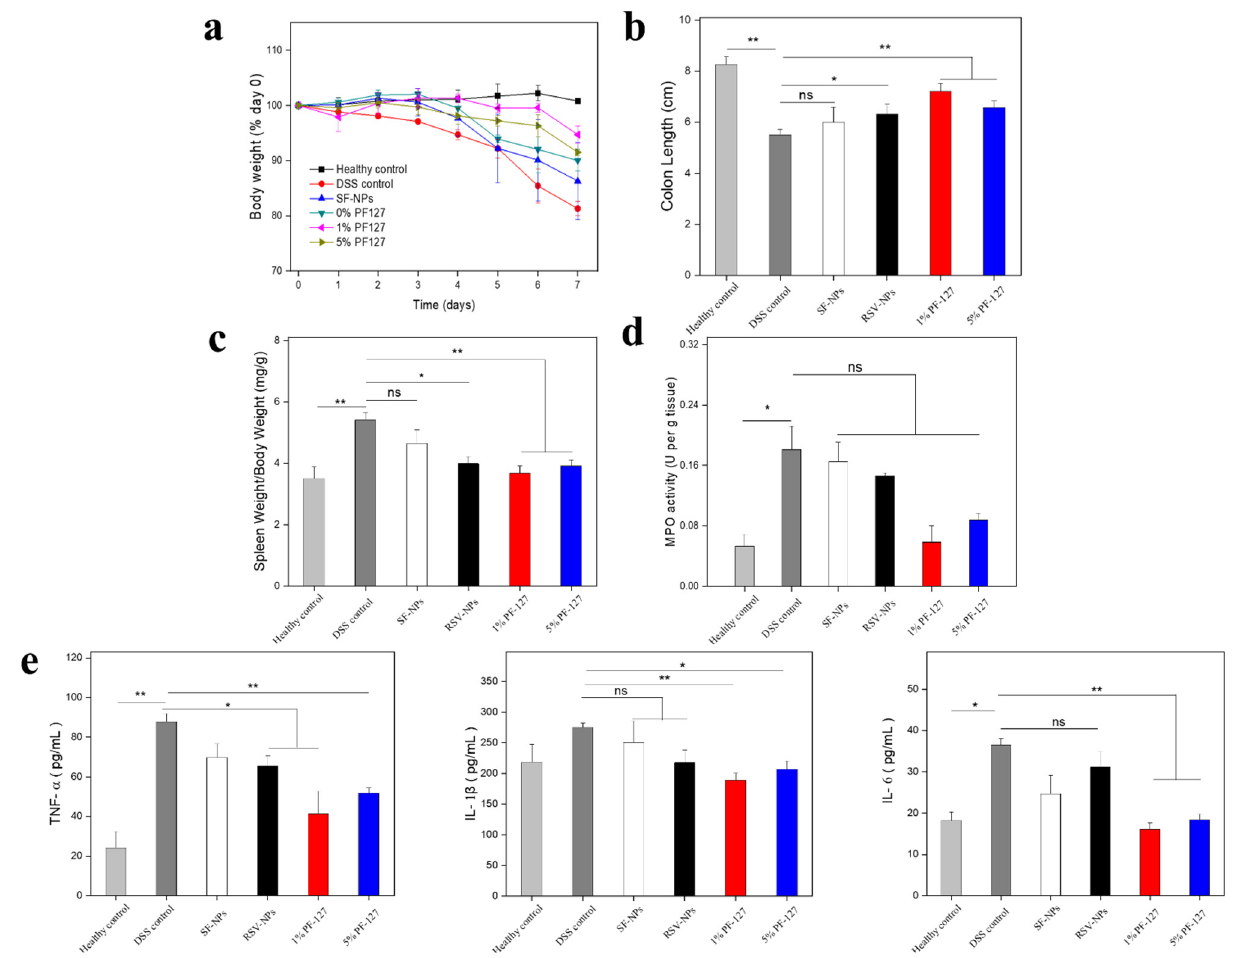
Figure 6. In vivo therapeutic effect of NPs against UC via oral administration. ( a ) Time-dependent variations of body weight over time, normalized to the percentage of the day-zero body weight. ( b ) colon length, ( c ) spleen weight, and ( d ) colonic MPO activity in different mice. ( e ) TNF- α , IL-1 β , and IL-6 concentrations in serum. Each point represents the mean ± S.E.M. ( n = 5; * p < 0.05, ** p < 0.01, and ns = no significance).